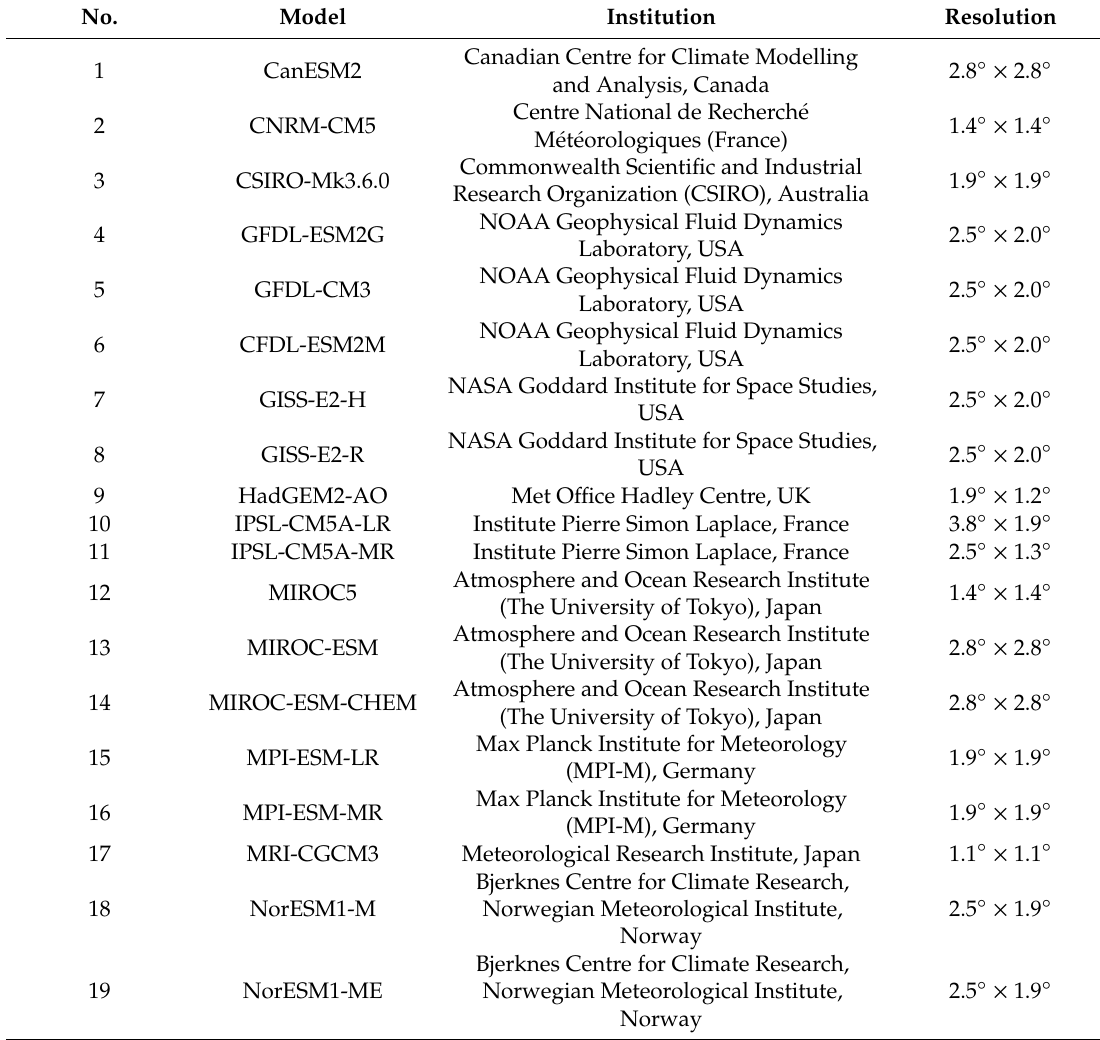
Table 1. The Coupled Model Intercomparison Project (CMIP5) models adopted in the present study.